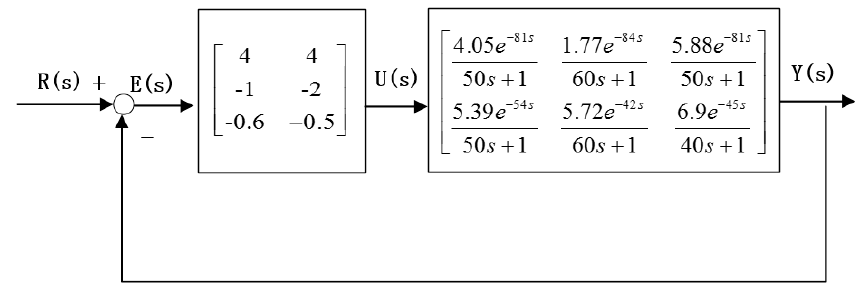
Figure 12. The diagram of the Shell closed-loop control system.